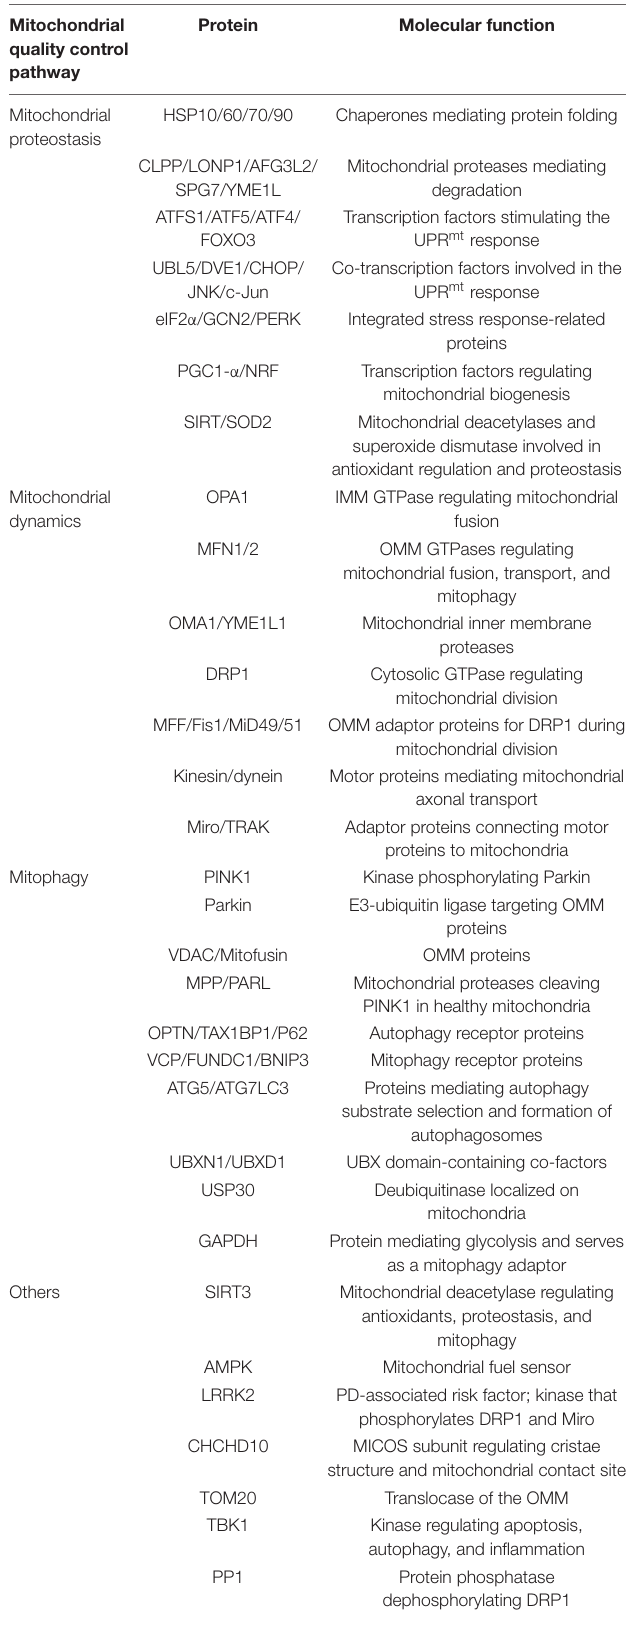
TABLE 1 | Proteins associated with mitochondrial quality